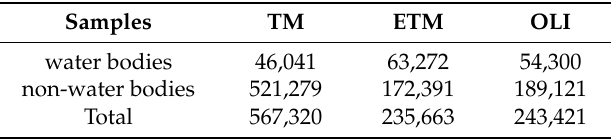
Table 2. Collected sample size of different sensor